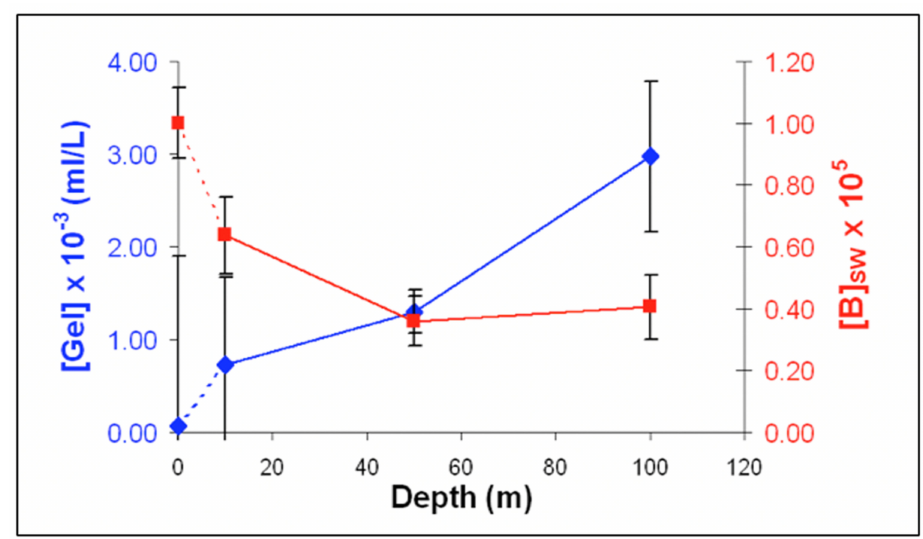
Figure 25. Images of four fields captured at 1200 × magnification, covering 60–80 µ m 2 each were randomly selected and recorded in each of five filters containing fluorescently labeled gels and bacteria found in the surface, 10, 50, and 100 m deep seawater samples. These images yielded 105 data sets reporting the count of MG and free MB found in each of the fields. These numbers were then averaged and scaled to the 78 mm 2 areas of the filter to render the concentration of bacteria in seawater ([MB]SW = Σ BSW × mL − 1 SW) and the SW gels concentration ([MG] = Σ MG × mL − 1 SW) found in the 100 mL of seawater that passed through each filter. The volume of each MG (VMG) was calculated from the area and thickness of each serial optical section and the number of sections in the stack.